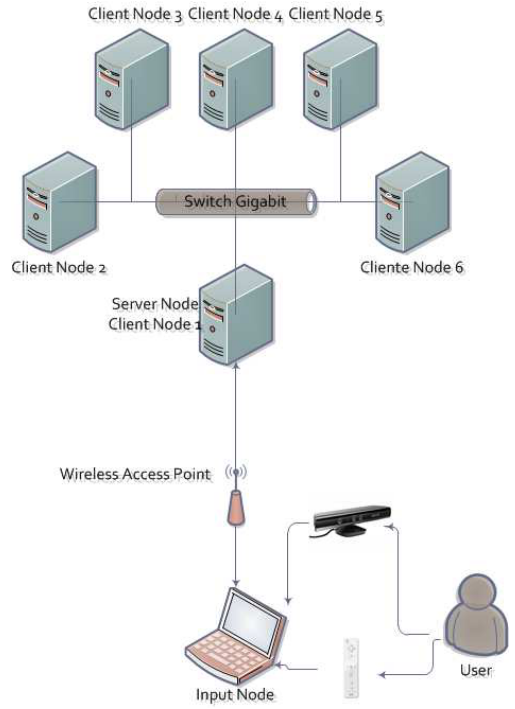
Fig. 8 - Our infrastructure for running the application in the mini-CAVE Figure 9 presents the digital “ Torre de Papel ” running in a 3-sided mini-CAVE.